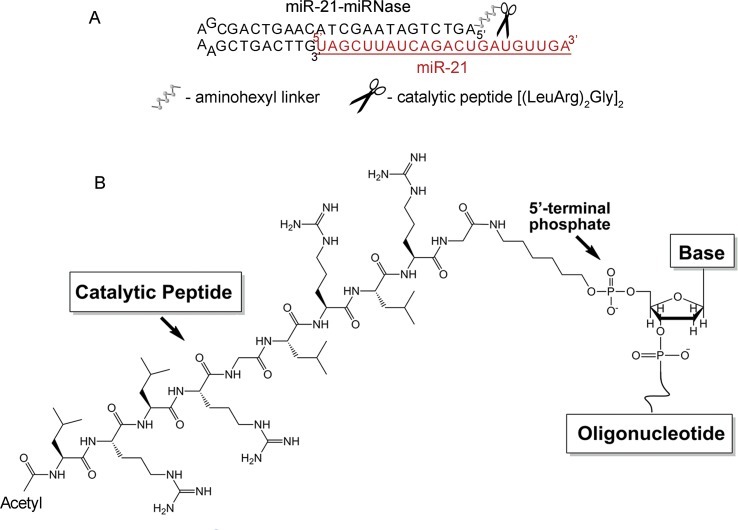
Structure of the miR-21-targeted peptide-oligonucleotide conjugate, miR-21-miRNase. (A) Sequence of oligonucleotide part of miRNase and schematic representation of a general complex of miR-21 and miRNase. (B) Chemical structure of miRNase. The peptide acetyl-[(LeuArg)2Gly]2 was covalently attached via its C-terminus to the aminohexyl linker located at the 5′-terminal phosphate of the antisense oligonucleotide.